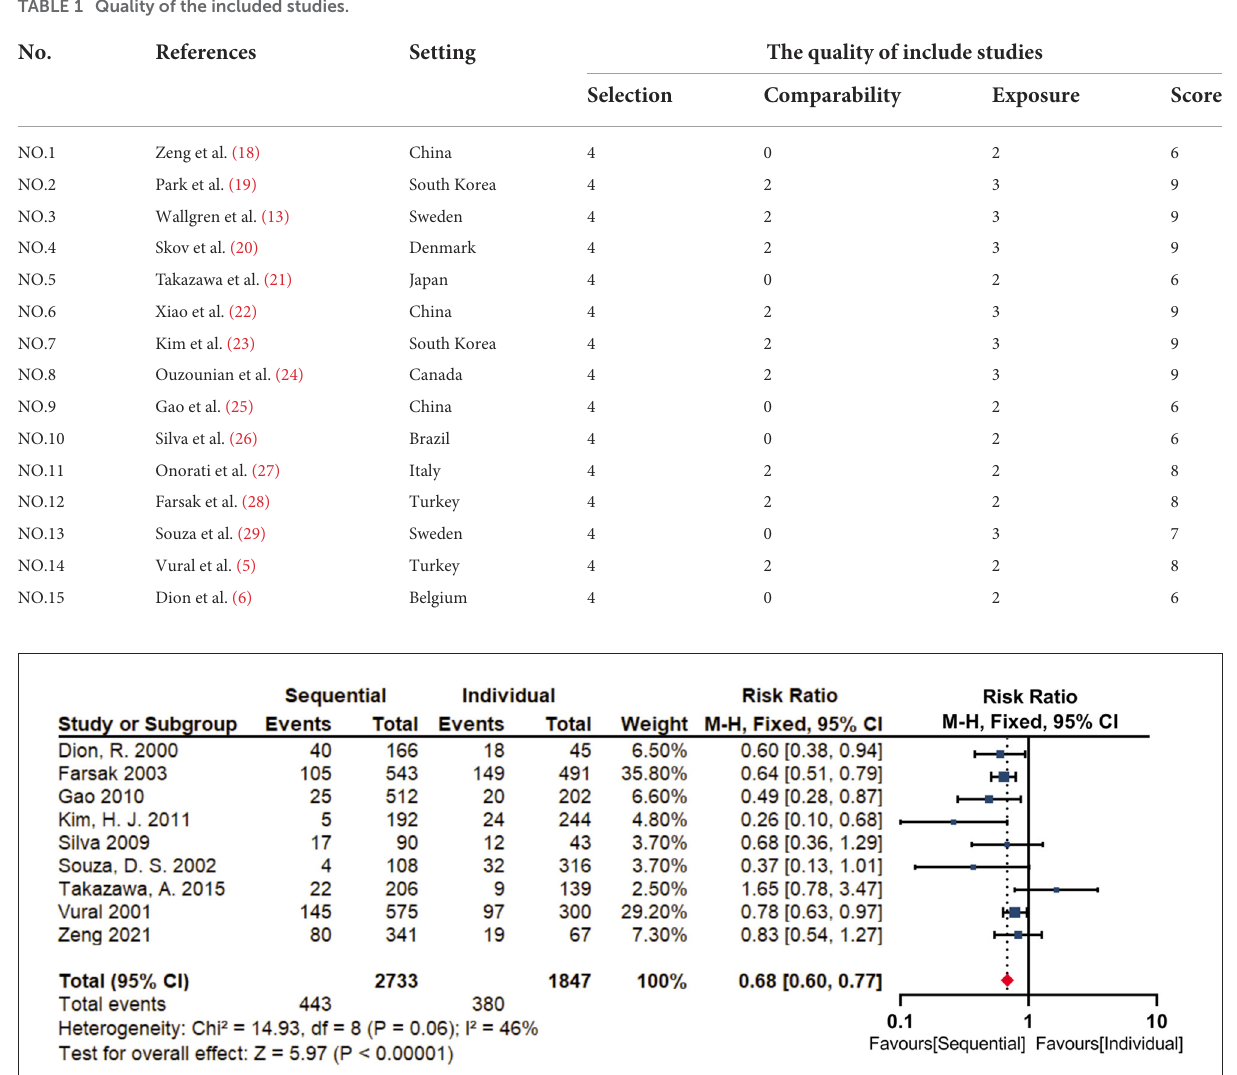
TABLE 1 Quality of the included studies.